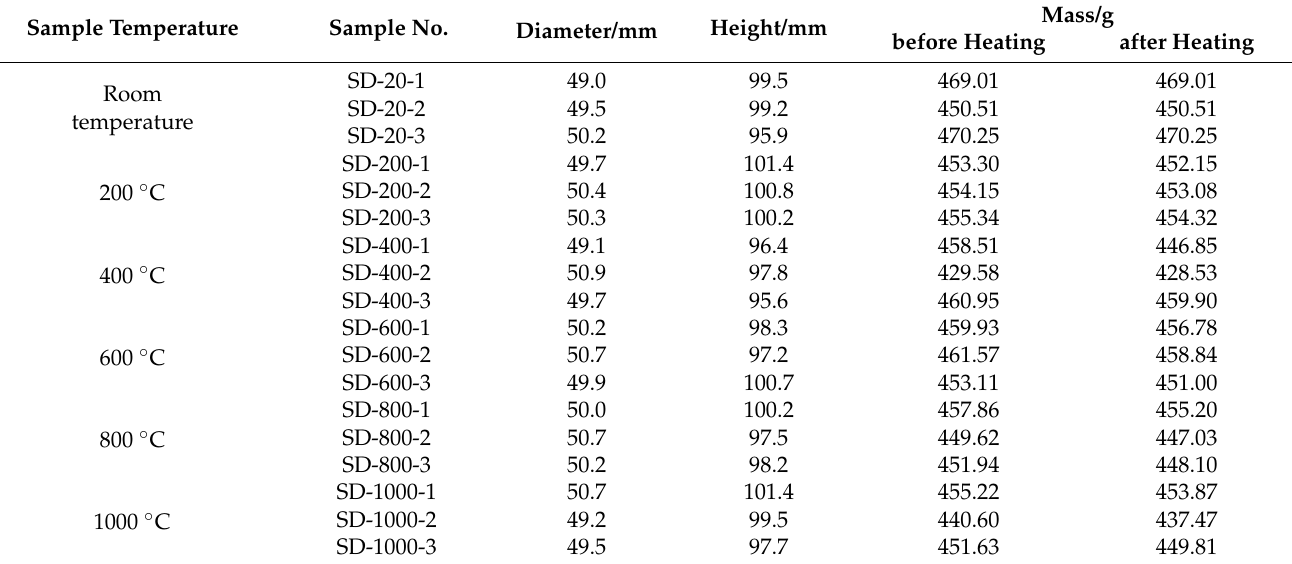
Figure 1. Schematic diagram of the sampling site for sandstone samples [30]. Table 1. Physical parameters of rock samples [30].